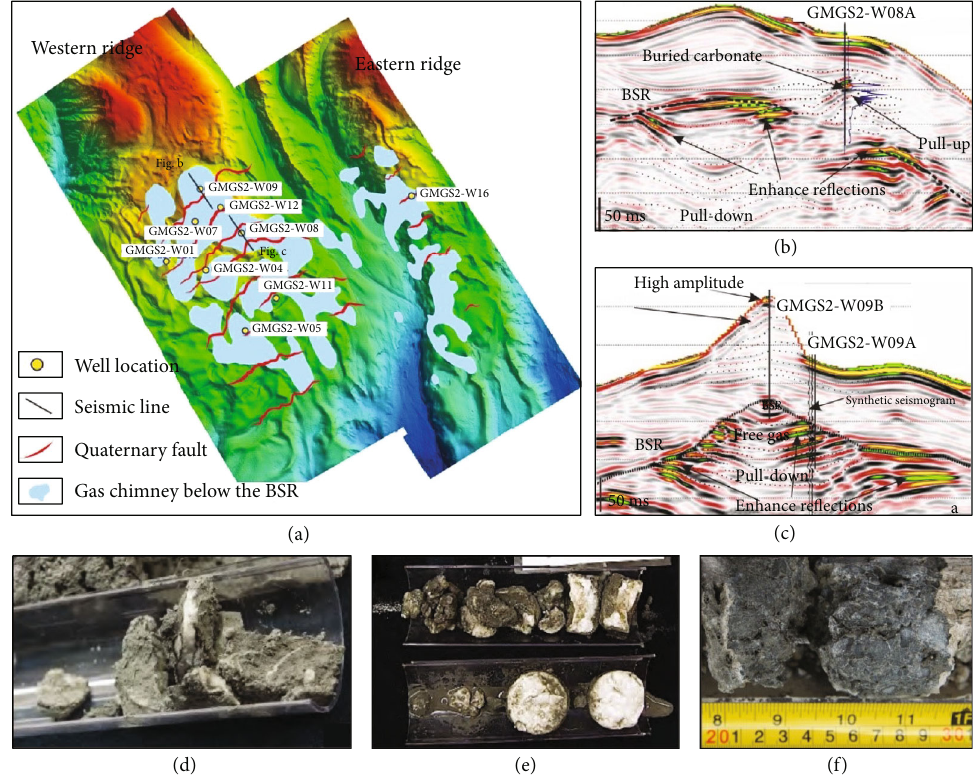
Figure 7: (a) Distribution of gas chimneys, faults, and gas hydrate drilling sites for the GMGS2 expedition drilling zone in the Dongsha area. The locations of the drilling sites are from Konno et al. [53] and Zhang et al. [85]. (b) and (c) Seismic pro fi les showing the gas hydrate accumulation features at the drilling and coring sites, where gas hydrates and buried carbonates were con fi rmed via logging and pressure coring (modi fi ed from Konno et al. [53]). (d) and (e) Massive gas hydrate samples collected from site GMGS2-W08 [133]. (f) Carbonate rock recovered from site GMGS2-W08 (modi fi ed from Zhong et al.